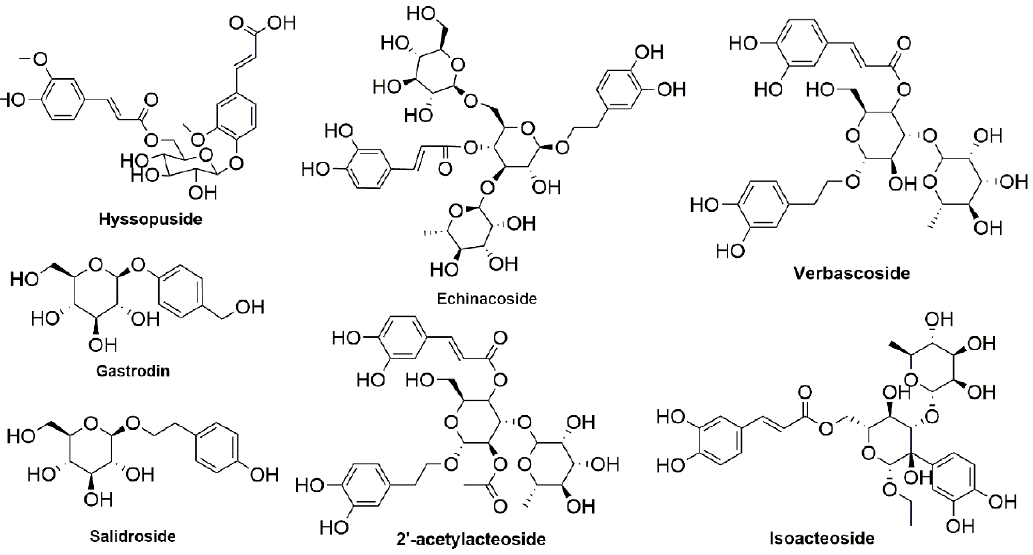
Figure 1. Chemical structures of phenolic glycoside with anti-inflammatory activity and hyssopuside.